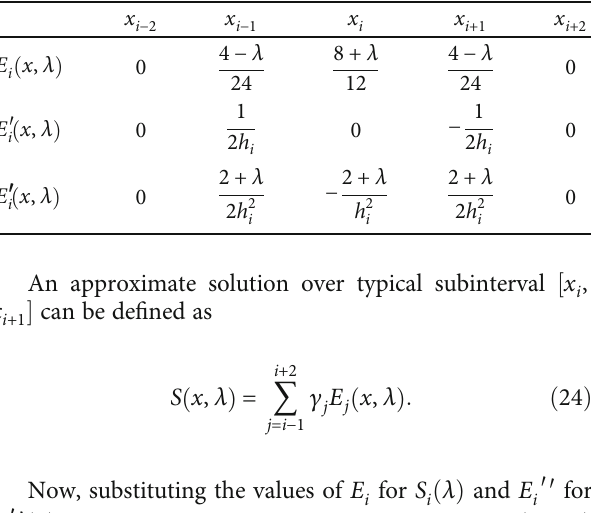
ð x , λ Þ and its derivatives at nodal i